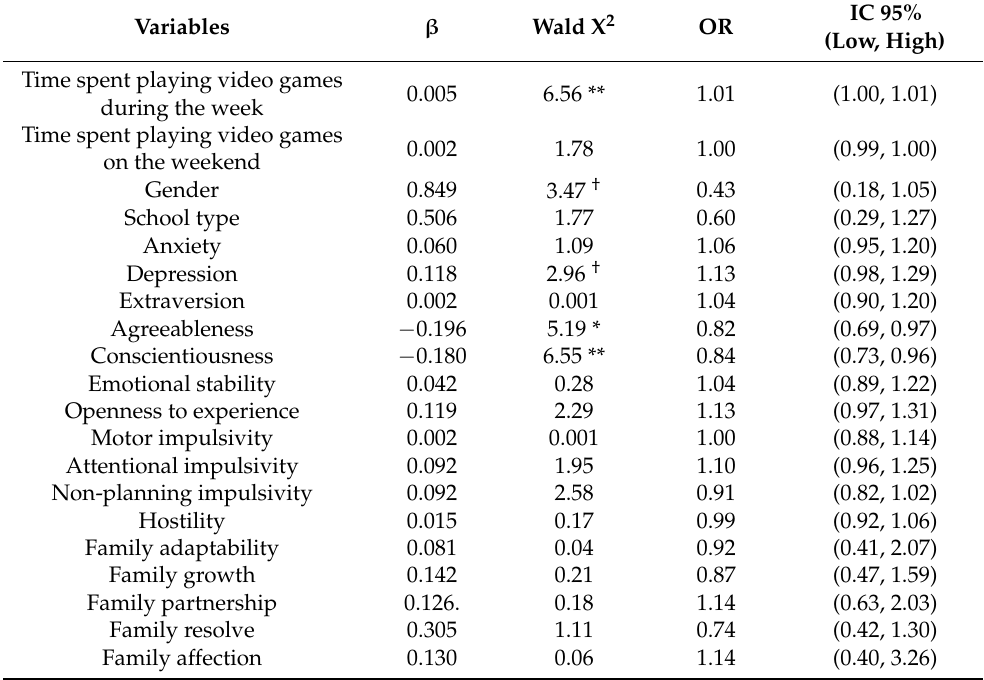
Table 6. Logistic regression analysis of the predictive variables of the T1 on IGDs in T2.